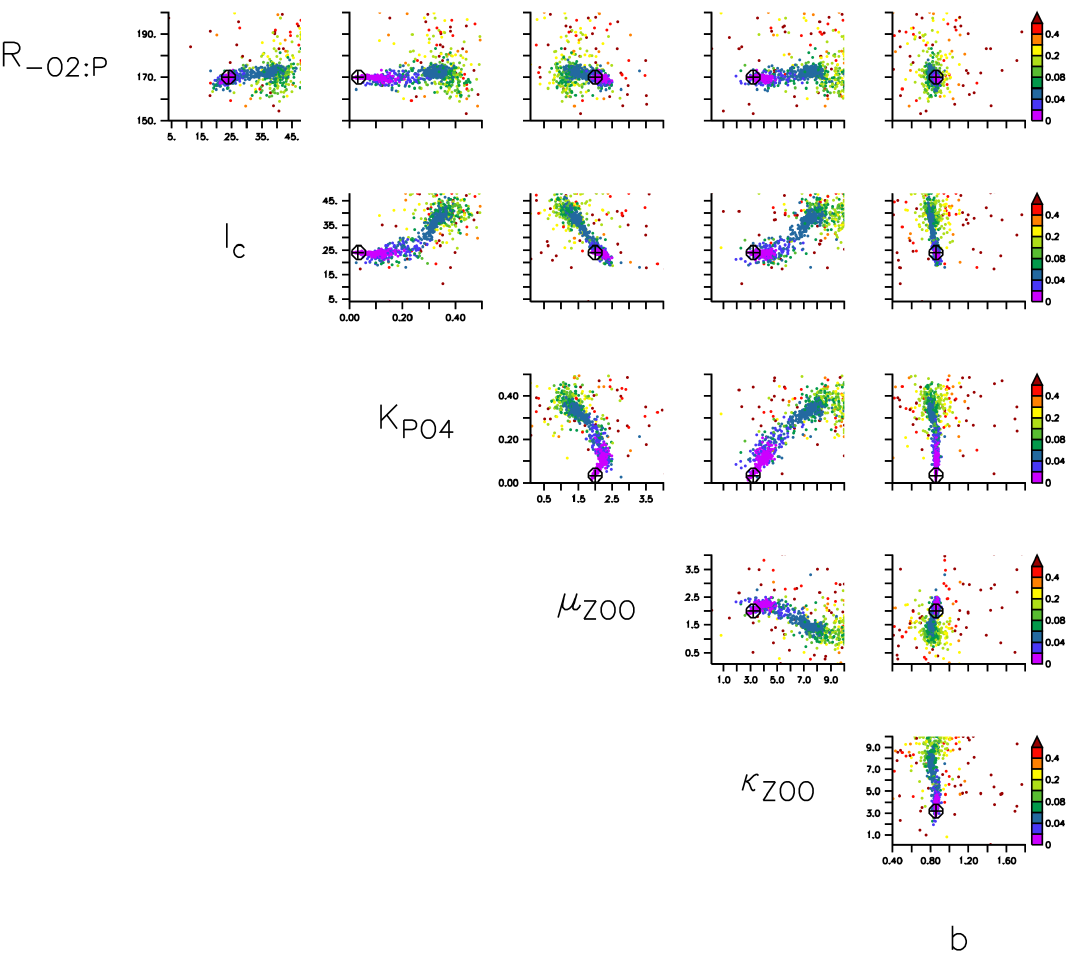
Figure 5. Model misfit, plotted for each pair of parameter combinations of the twin experiment. Color indicates misfit (see the color bars on the right). A cross indicates the target value, i.e., the value of the reference experiment. A circle indicates the parameter of one individual of the last generation. Note that for better visibility we restrict the parameter range to its boundaries (see Table